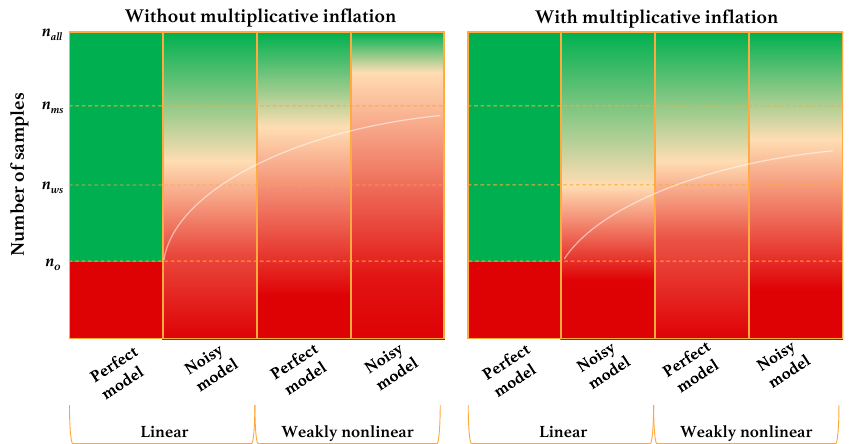
Figure 5. Conceptual representation of the number of samples necessary to prevent divergence of the EnKF in different filtering regimes. Dark green represents near-optimal filter performance and dark red represents filter divergence. In perfect-linear models, only n 0 samples are needed for an asymptotically optimal performance. Without inflation, in noisy linear and perfect, weakly-nonlinear regimes, near optimal performance can be obtained by correcting error in all modes up to the moderately-stable BLVs – here n ws corresponds to the number of unstable/neutral/weakly-stable modes, while n ms furthermore includes moderately-stable modes. Additional samples may be necessary to control error growth with noisy, weakly-nonlinear evolution. Multiplicative inflation corrects for the upwelling from the uncorrected stable modes so that near optimal performance can be obtained when the error growth in unstable/neutral/weakly-stable modes are corrected.